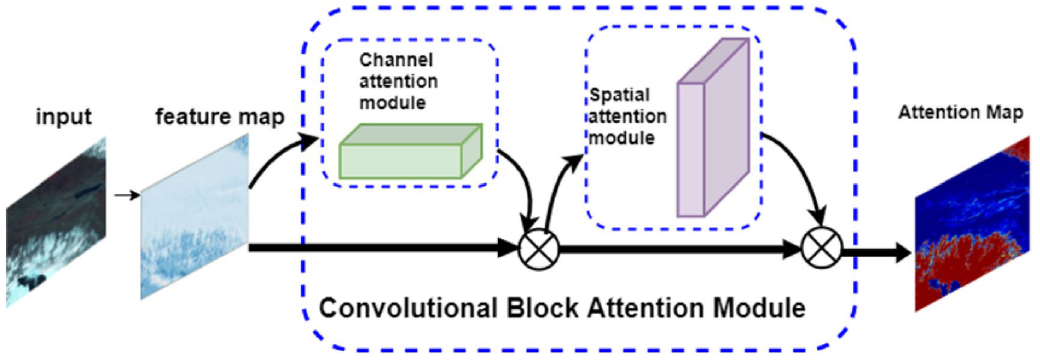
Figure 6. Schematic diagram of CBAM.